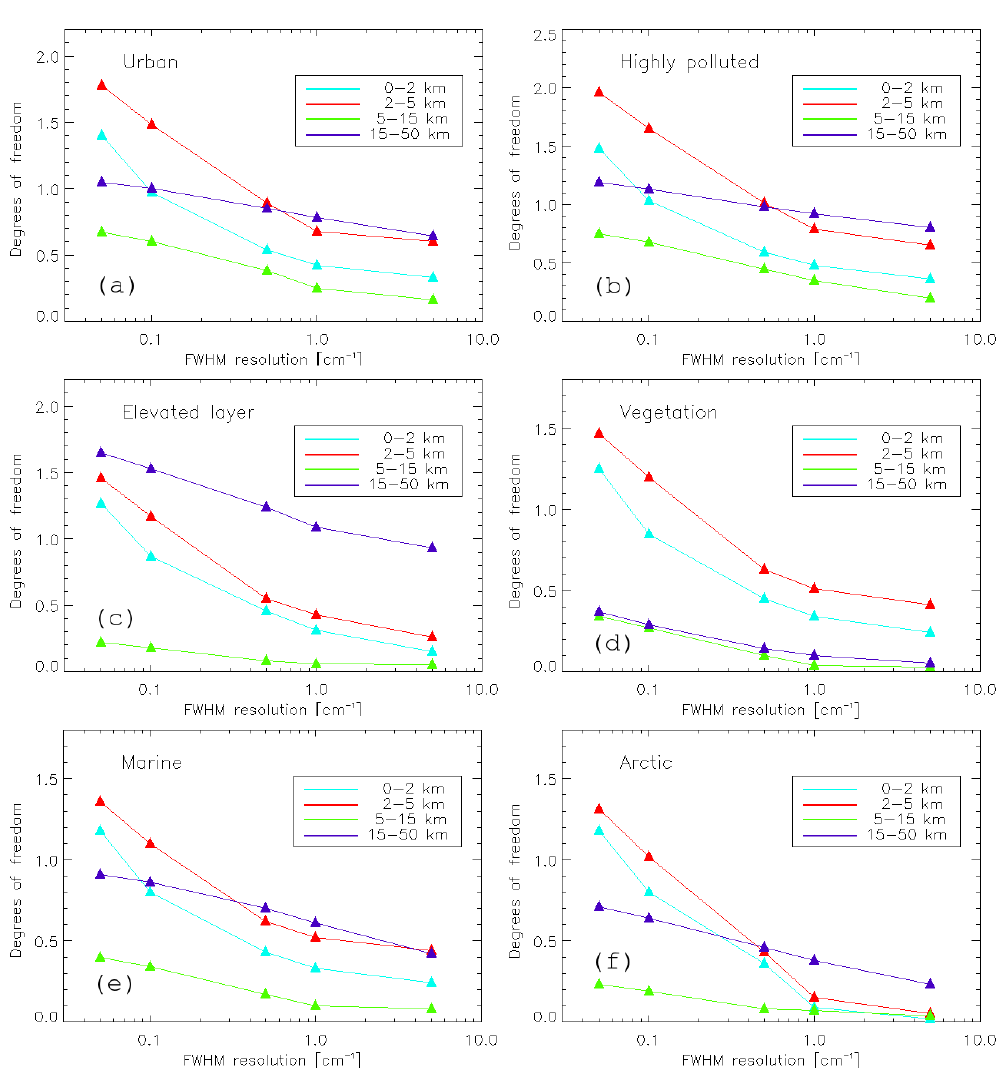
Figure 7. DoF calculated for four different altitude ranges to enhance the tropospheric contribution with respect to the whole atmosphere for every single aerosol scenario are shown in (a–f)